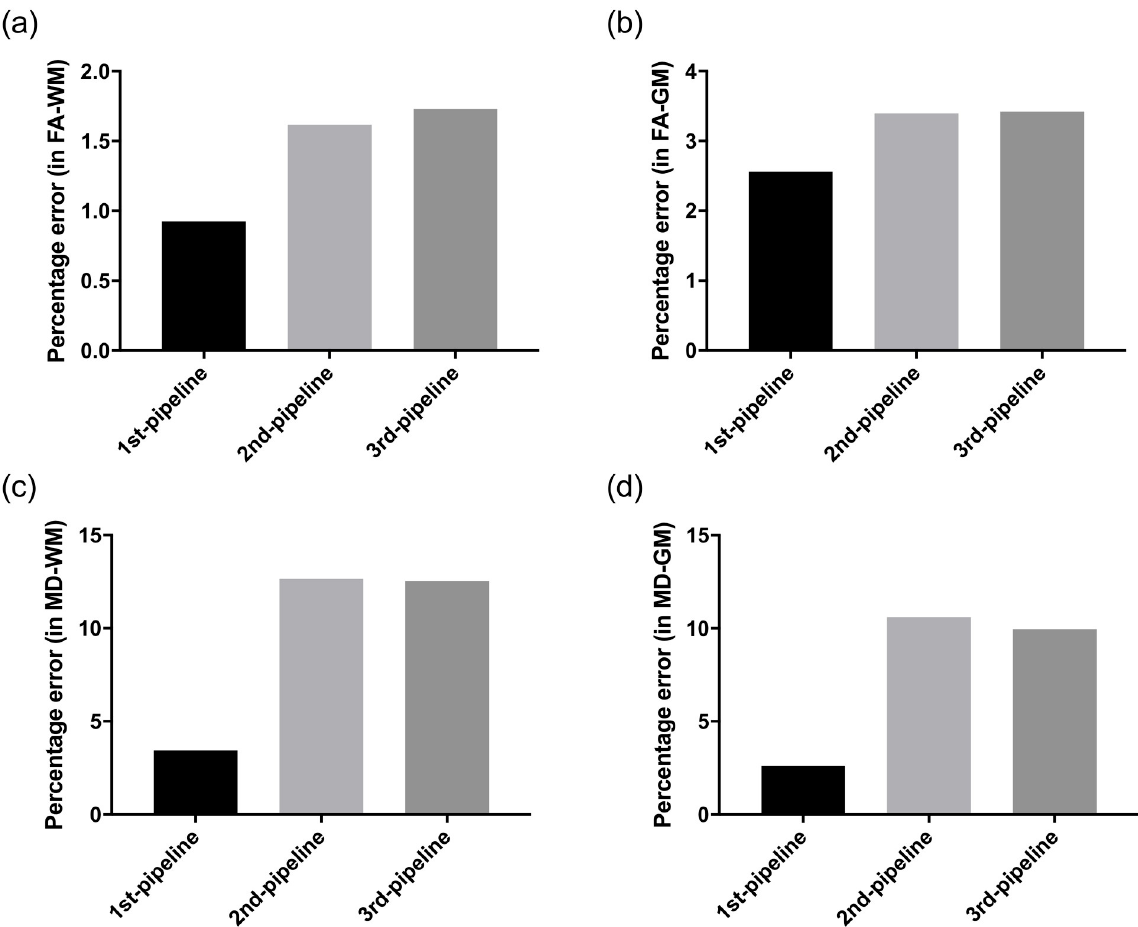
Fig 5. Processing error associated with the pipelines for FA calculation in (A) WM and in (B) GM, and MD calculation in (C) WM and in (D)